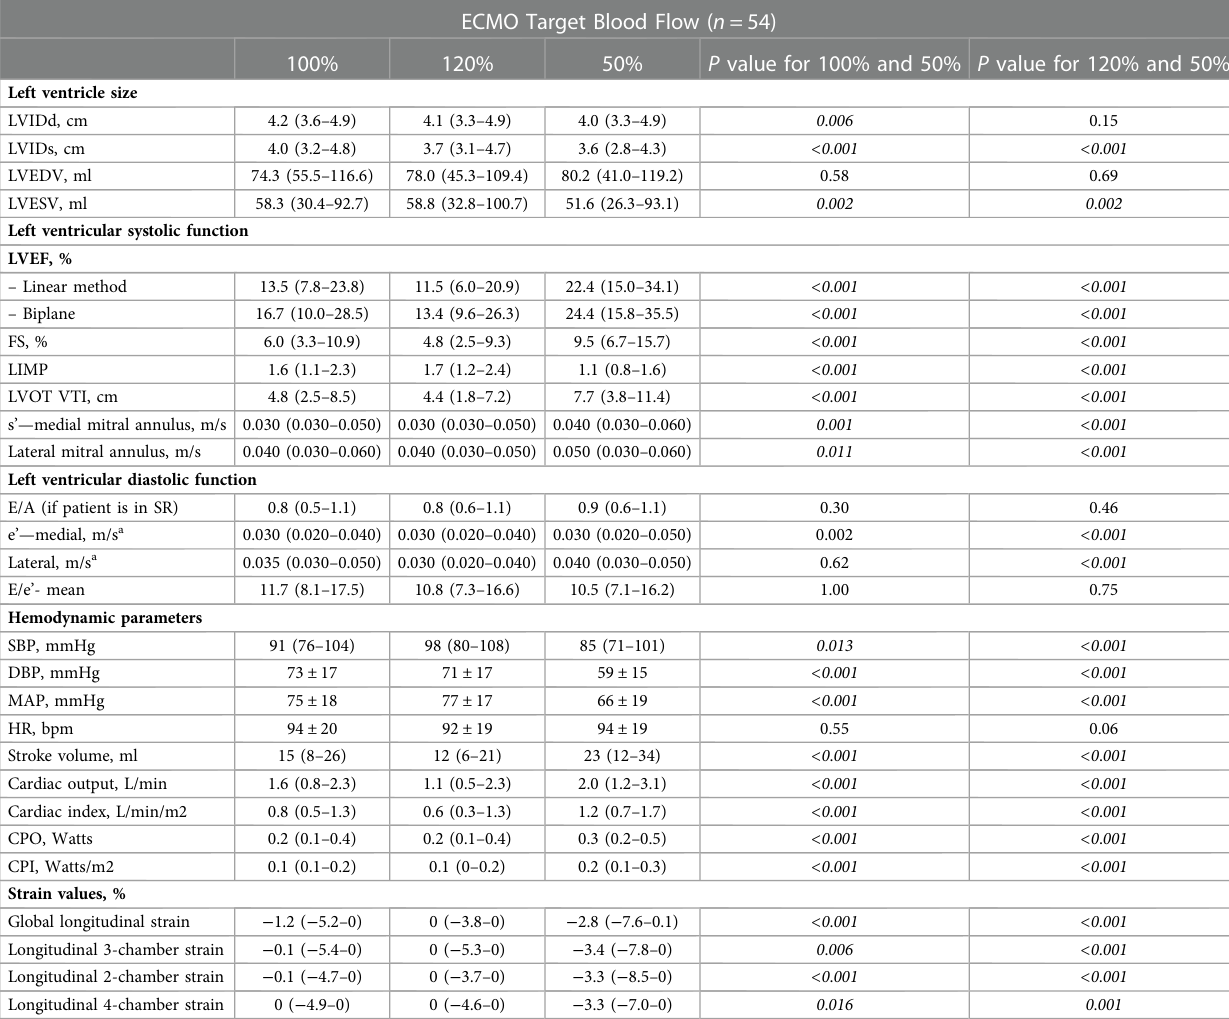
TABLE 2 Comparison of Echo fi ndings at different levels of ECMO target blood fl